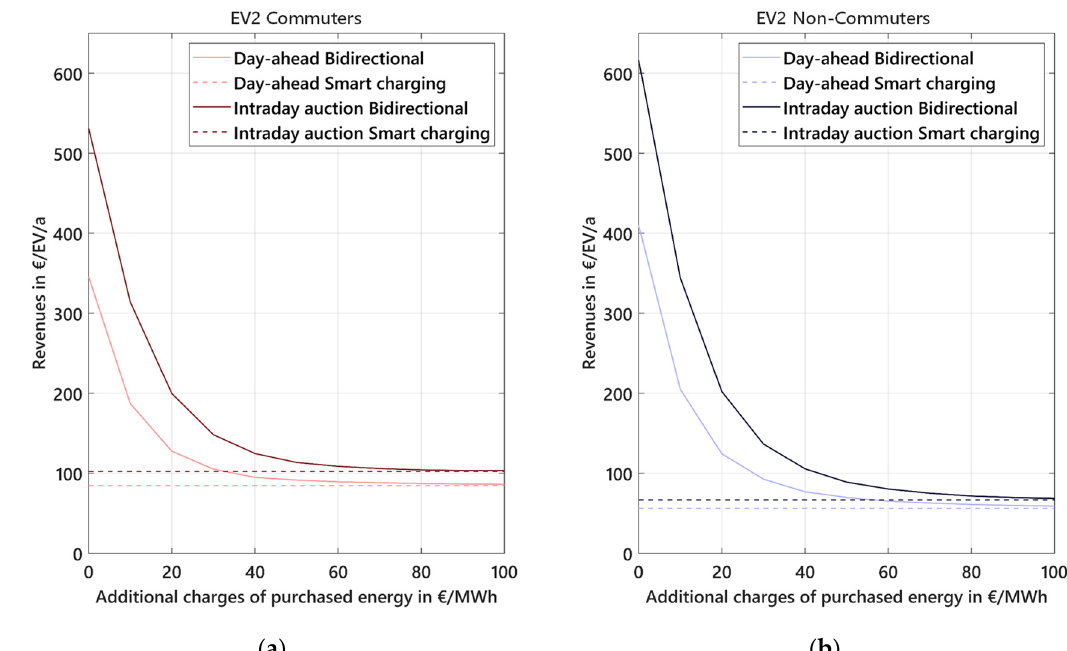
Figure 9. Influence of additional charges for purchased energy on revenue potentials of bidirectionally chargeable EVs compared to revenues of smart charging in the day-ahead market and intraday auction for commuters ( a ) and non-commuters ( b ).